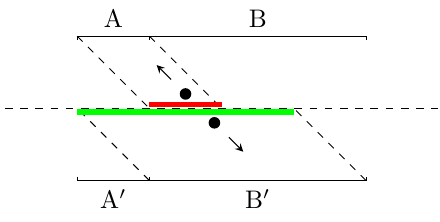
Figure 7 . Left: light cone singularity associated with eq. (2.32). Center: light cone singularity associated with eq. (2.33). Right: the two light cone singularities are tangled.